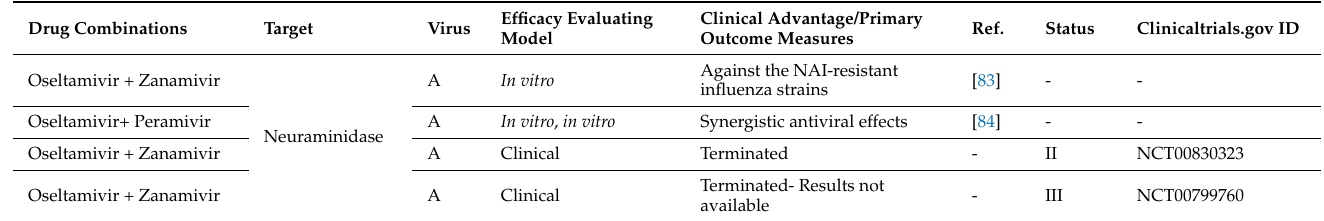
Table 3. Antiviral combination therapy targets the same proteins of the influenza